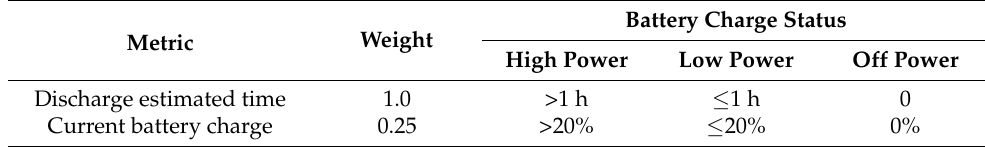
Table 3. Metrics and their thresholds for determining the battery charge